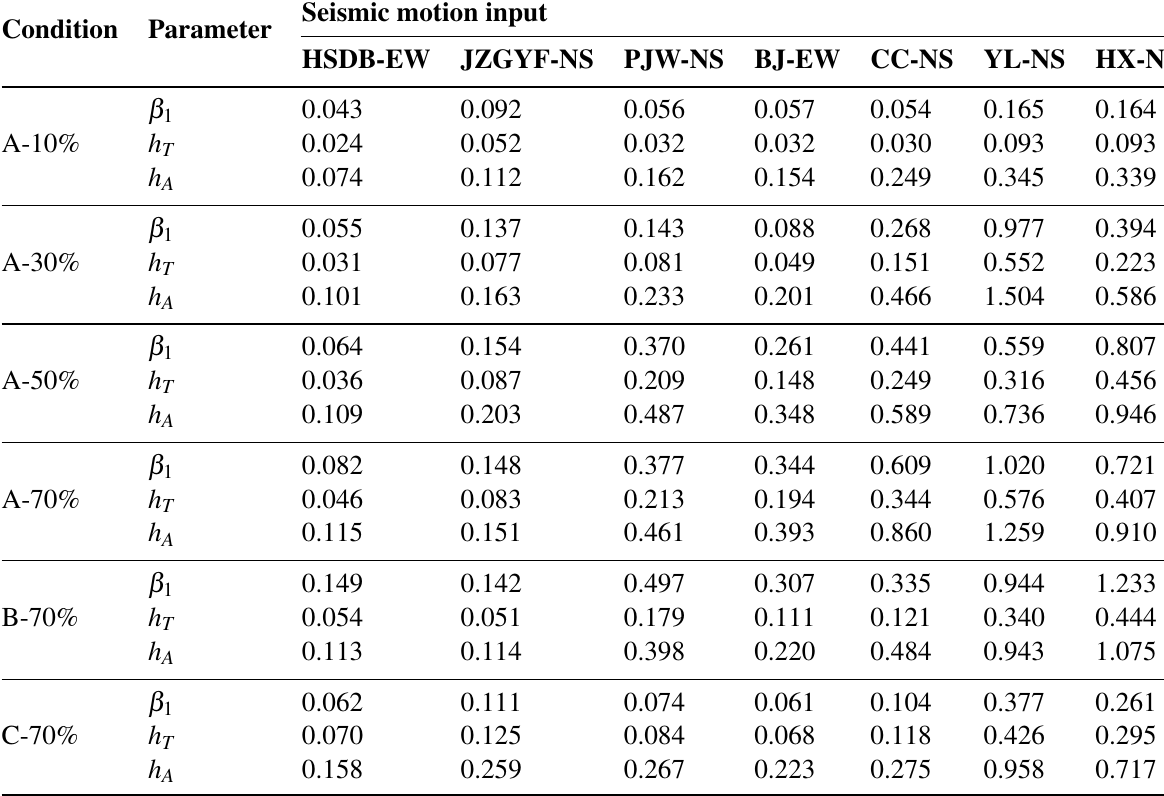
Table 3 The result of β 1 , h T , and h A under seismic actions with 100 gal peak